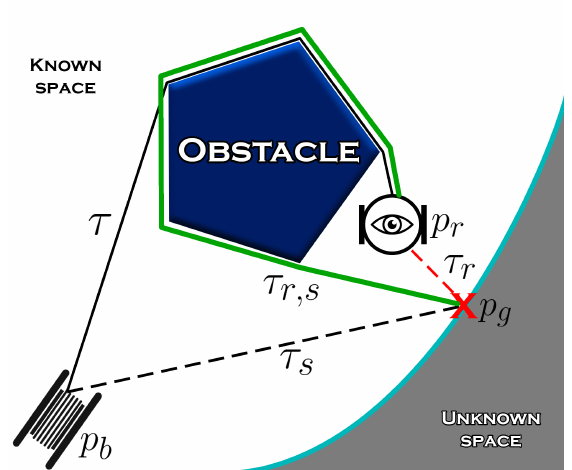
Figure 1. Visual representation of our proposed approach. The robot at the position p r with a tether τ connecting it to the base at p b compares the shortest path to the goal p g from the base ( τ s ) with the one from its current position ( τ r ), and takes the path τ r,s to return the tether to its shortest configuration and avoid further